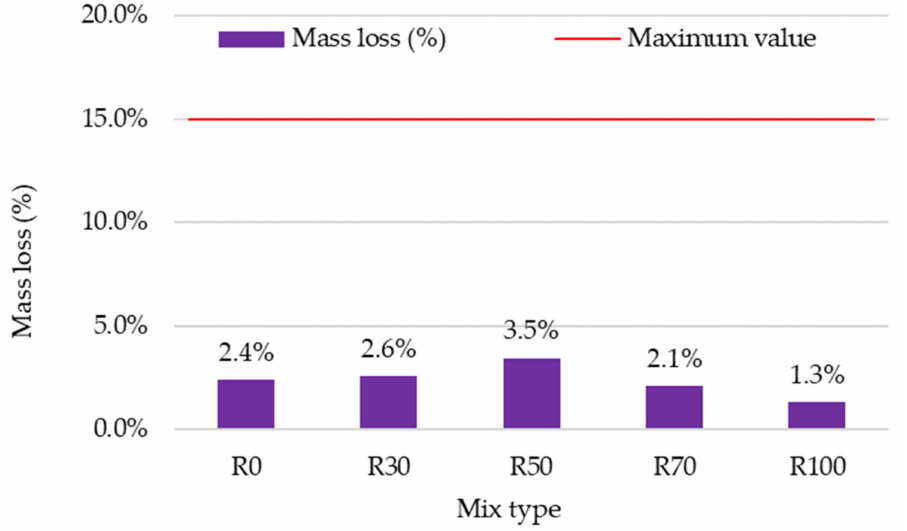
Figure 6. ML testing result for the five